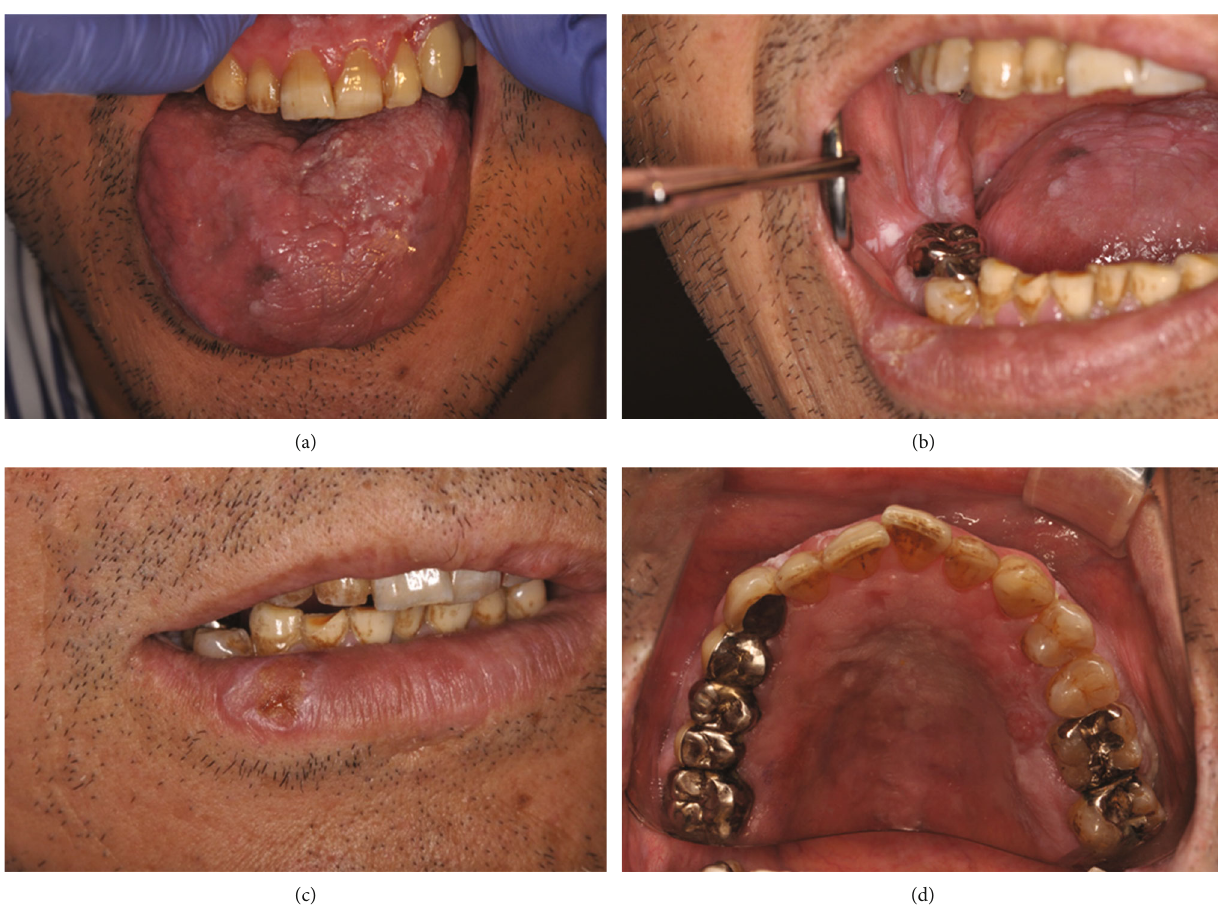
Figure 1: Clinical photographs (April 2019), (a) Erythema is observed on the right side and left margin of the tongue, and exophytic masses are found from the center to the left side of the dorsal surface. The left maxillary anterior gingiva shows whitish change. (b) The right buccal mucosa and pharyngeal mucosa shows lichenoid striae with erythema, in which white slightly raised lesions are observed, and white plaque is found posterior to the molar. (c) The right side of lower lip, a white lesion with a diameter of 7mm, with an indistinct border, no induration, is observed. (d) Most of the palate shows erythema. A relatively clear white ridge is observed on the right molar (Mirror